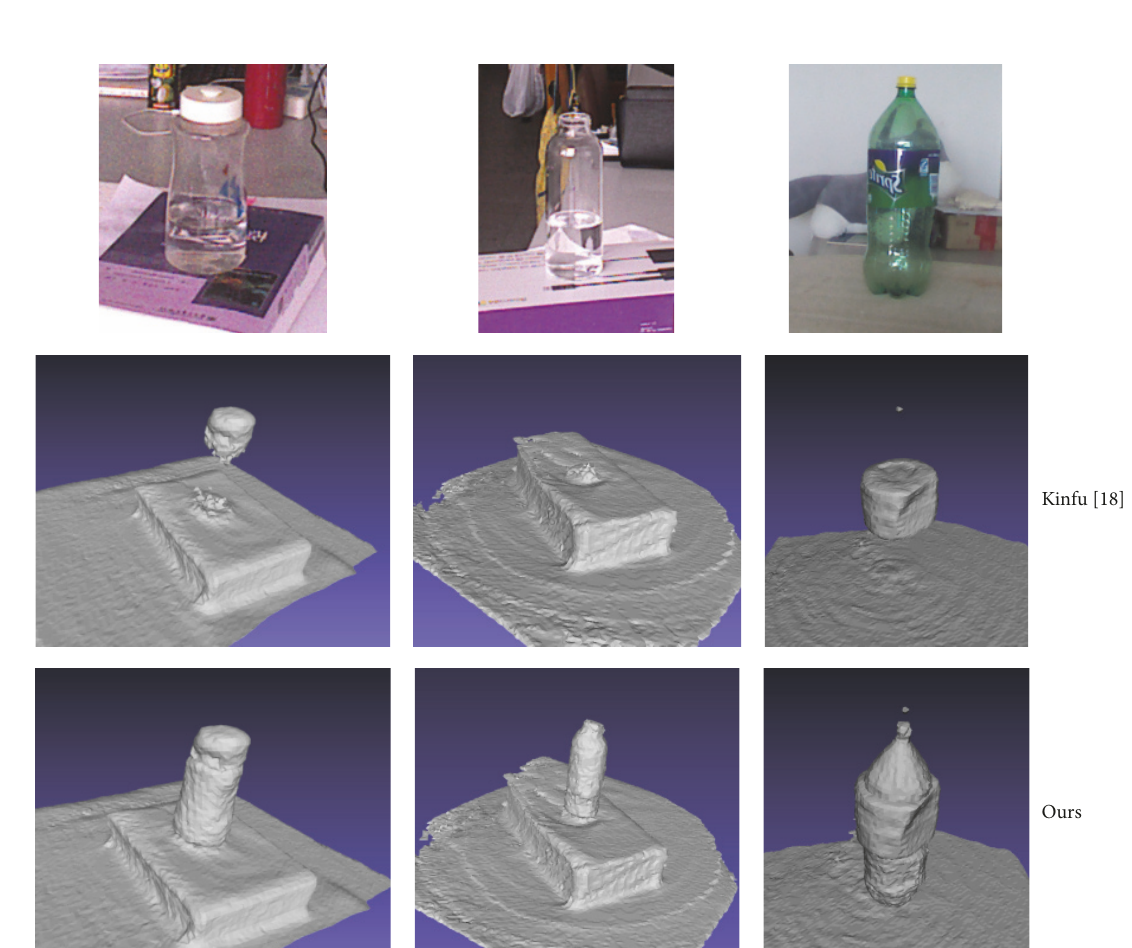
Figure 8: Comparison of 3D model scanned by Kinectfusion and our